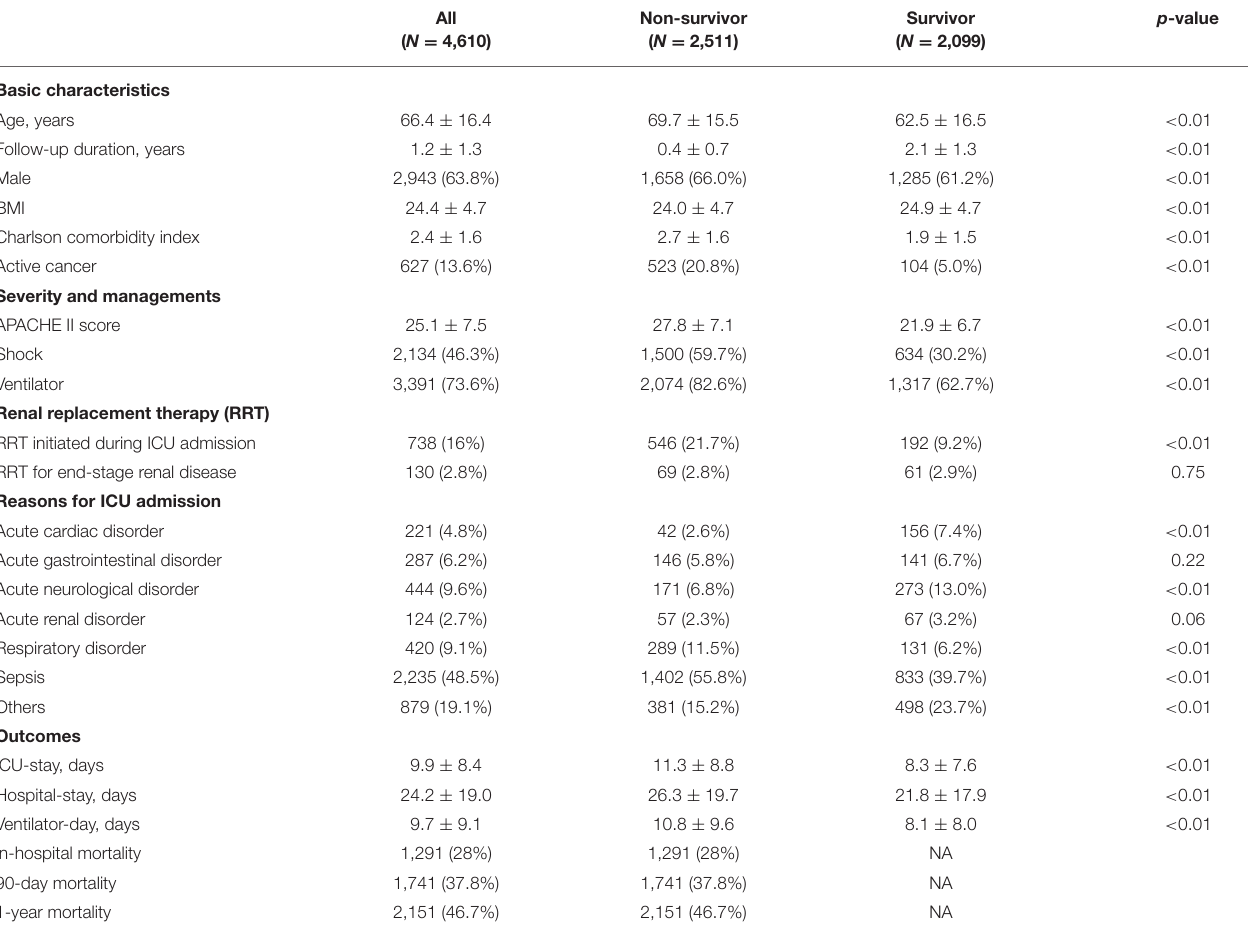
TABLE 1 | Patient characteristics by overall mortality ( N =